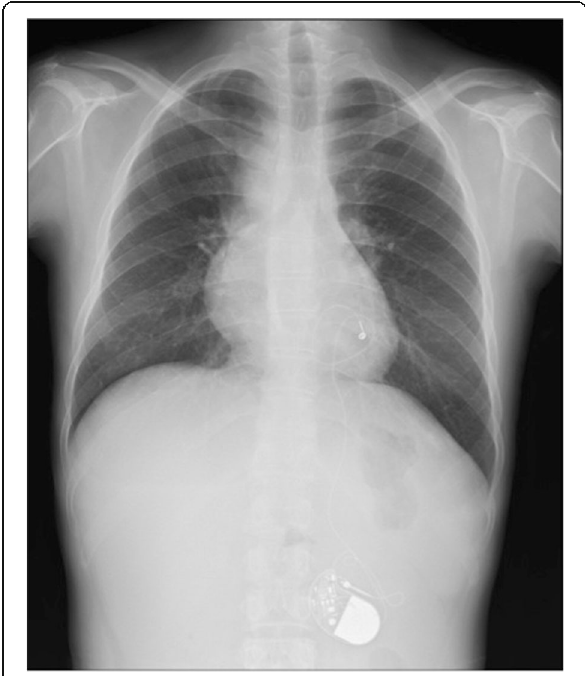
Fig. 1 Chest X-ray showed no congestion of bilateral lung field or a globular heart. Pacemaker is located at left upper quadrant